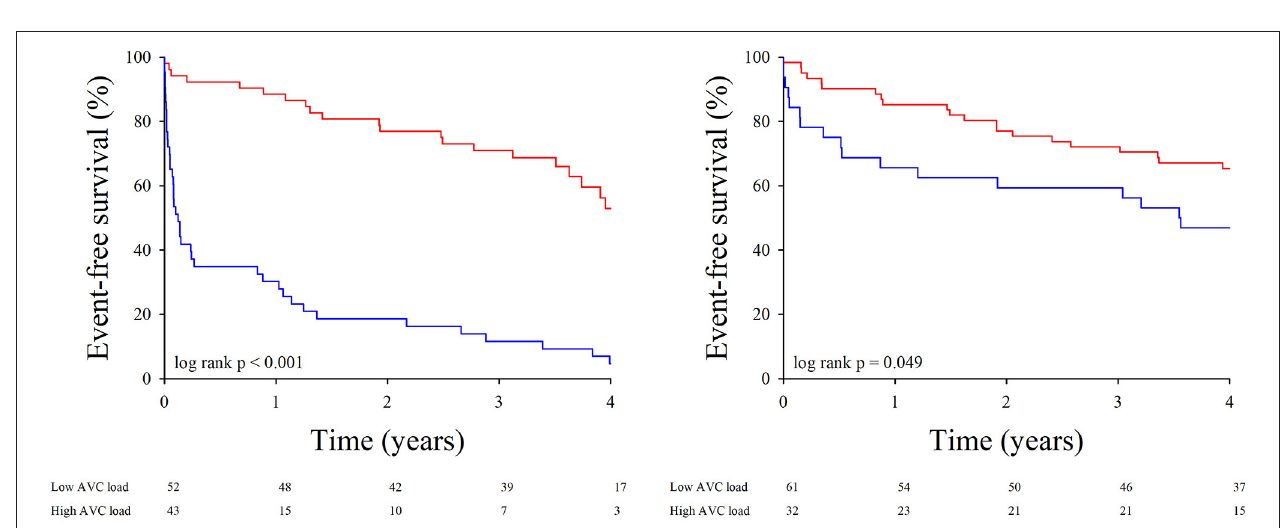
FIGURE 5 | Event-free survival according to AVC load and concordance in AS grading. Kaplan-Meier survival curves for the combined end-point of death and need for aortic valve replacement in patients with in patients with low (red line) and high (blue line) Agatston score. Left panel: patients with concordant AS grading; right panel: patients with discordant AS